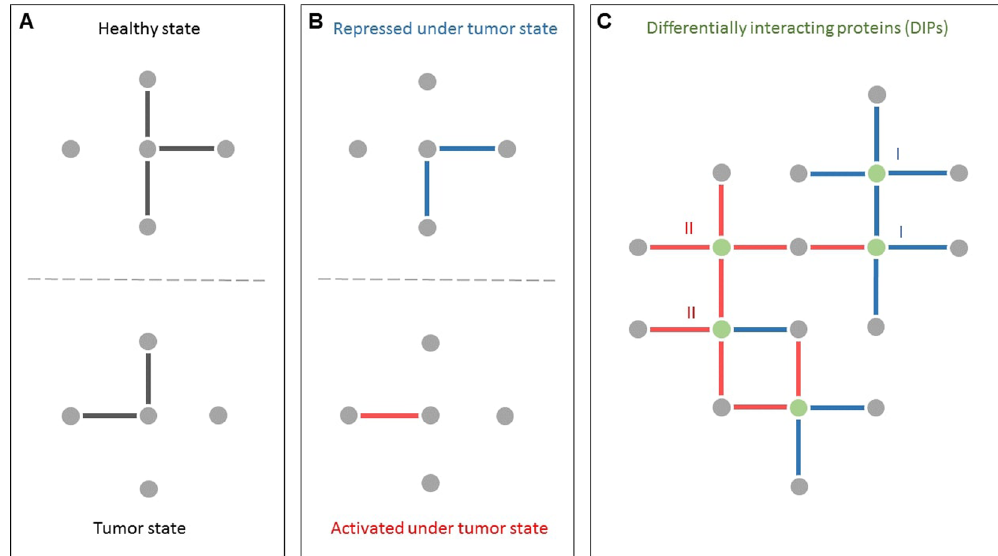
Figure 1. Schematic overview of differential interactome analysis between two phenotypes. ( A ) Highly probable protein-protein interactions (PPIs) in each phenotype. ( B ) Comparative analysis of interactome profiles of the phenotypes leads to the identification of differential PPIs, which are categorized into two groups as repressed or activated under the phenotype of interest (e.g., diseased phenotype). ( C ) Differentially interacting proteins (DIPs) representing significant changes in their interaction patterns during the transition between the